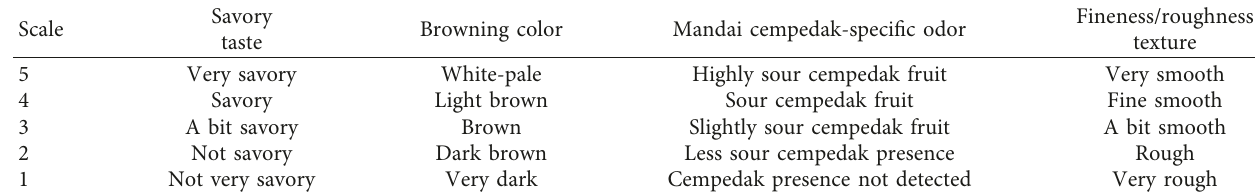
Table 2: Hedonic quality scale.